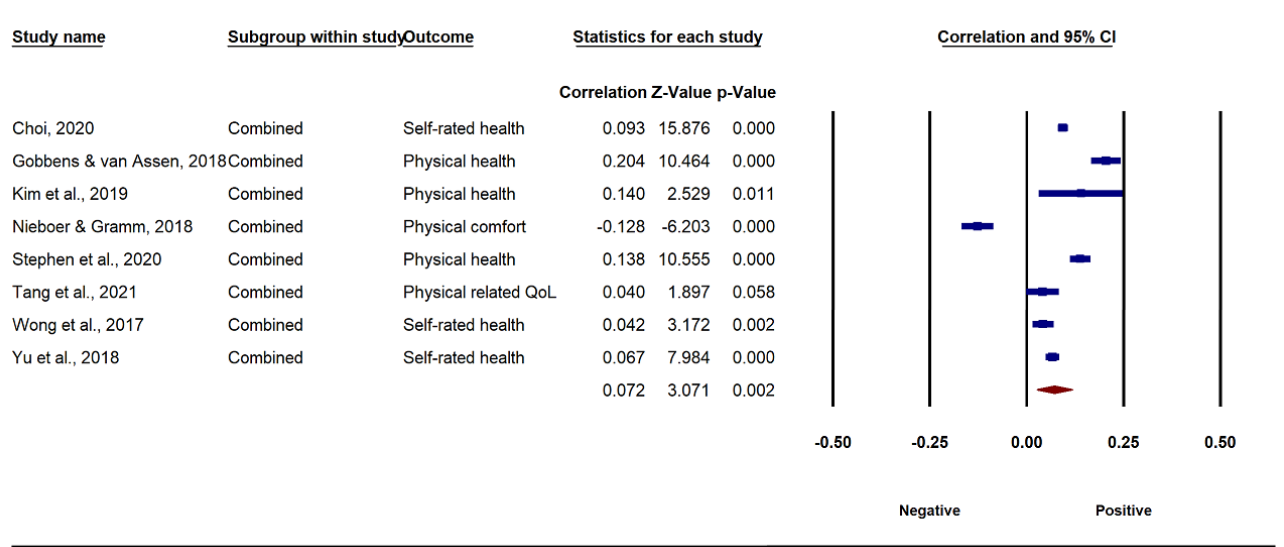
Figure 2. Forest plot of the association between AFEs and physical well-being.